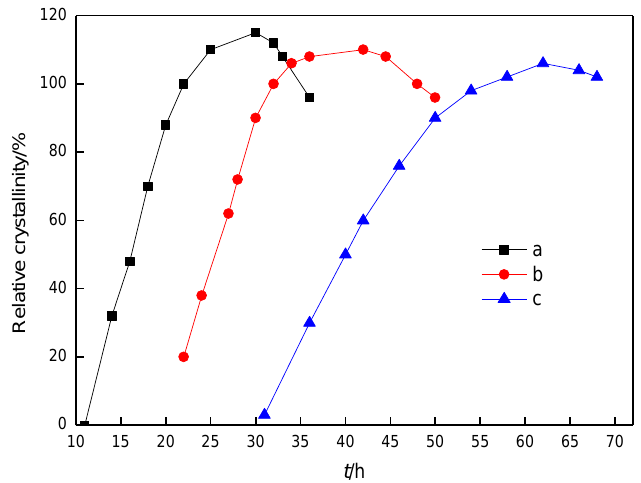
Figure 5. Crystallization fitting curves for synthesis of YST ( a ), YSG ( b ), YSV ( c ) composite molecular sieves at different nucleation stage temperatures.